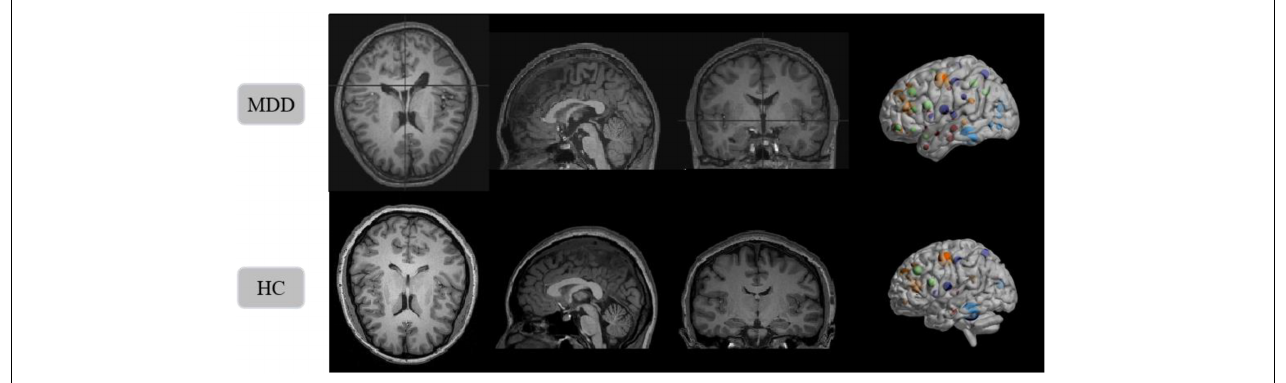
FIGURE 9 | Structural magnetic resonance imaging slice images from the MDD and HC in SHH dataset. Left to right: axial view, sagittal view, coronal view, and 3D presentation.